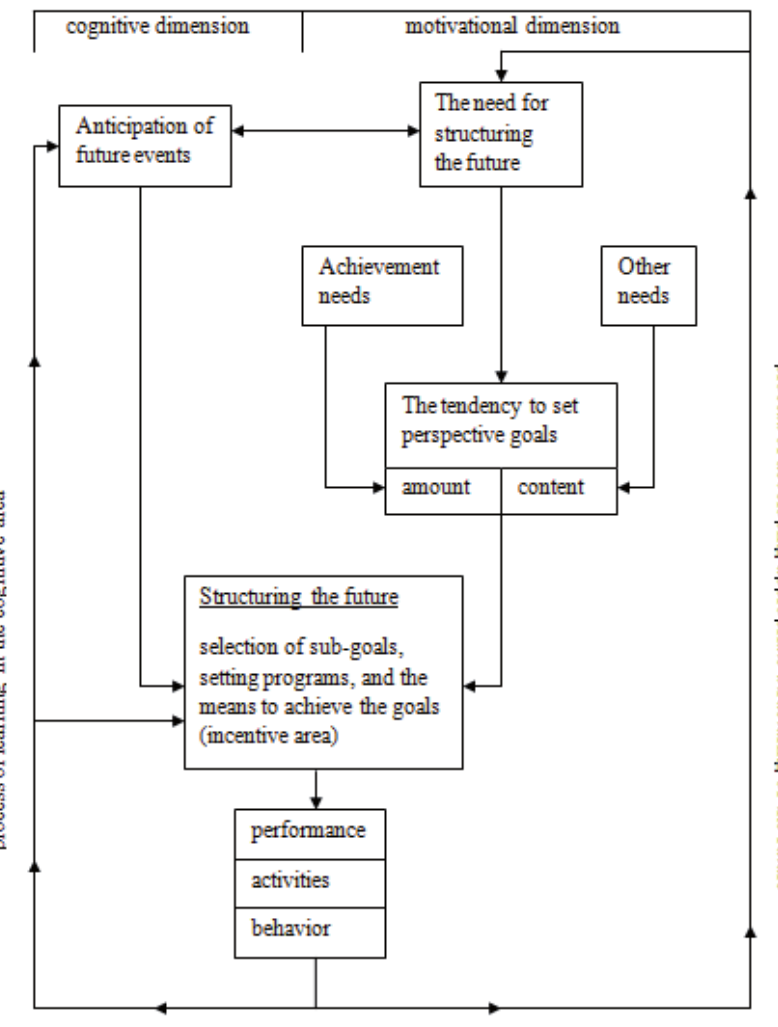
Fig. 1.: Model of perspective